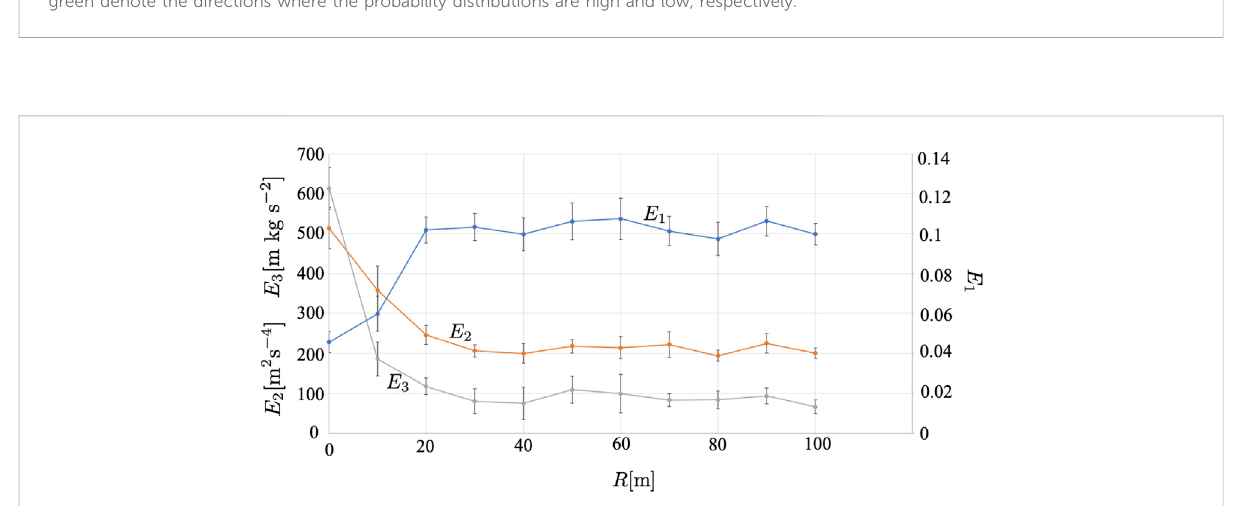
FIGURE 10 Result when the radius of the observation range R is varied. The average over fi ve trials is shown. The error bars denote the standard deviation.